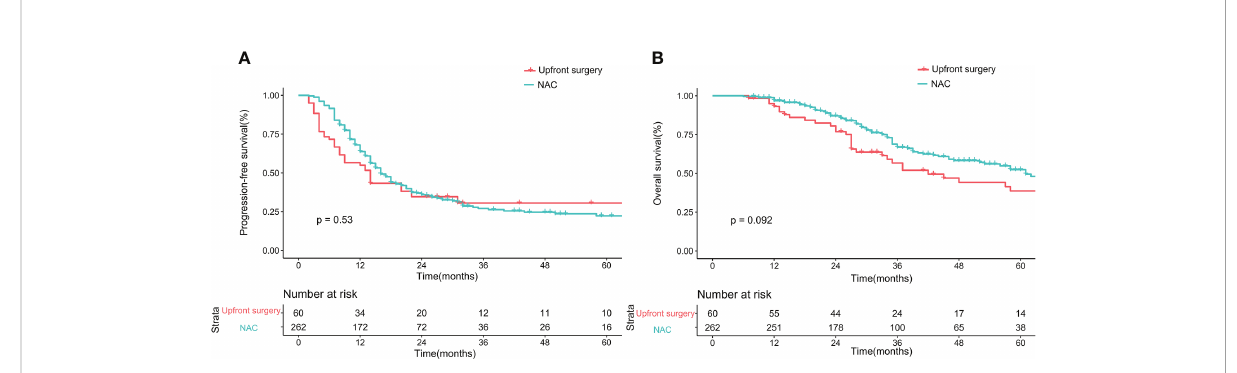
FIGURE 1 Kaplan-Meier curves for progression-free survival (A) and overall survival (B) between upfront surgery and neoadjuvant chemotherapy groups before 1:2 Propensity Score Matching Analysis. NAC, neoadjuvant chemotherapy.